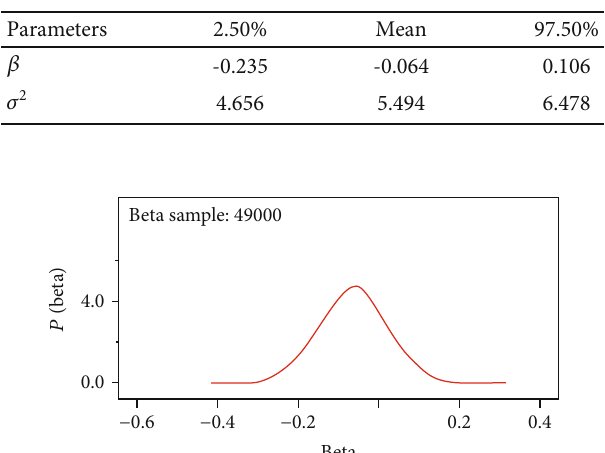
Table 2: 95% HPDIs.